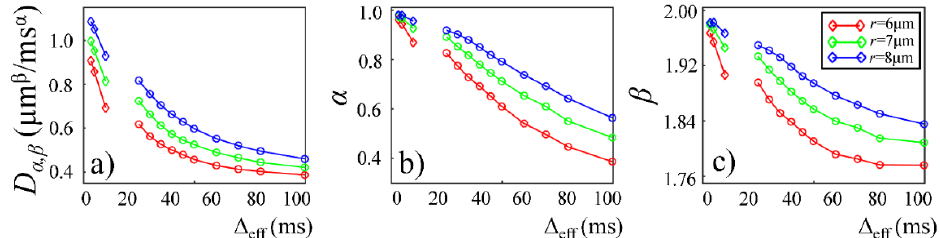
Figure 10. Plots of D α,β ( a ), α ( b ), and β ( c ) versus Δ eff from Monte Carlo simulation with fixed p = 0.2% and varying r of 6 µm (red), 7 µm (green) and 8 µm (blue). The rhombi and circles represent simulation results with oscillating diffusion gradient (OGSE) and Stejskal – Tanner diffusion gradient (PGSE/PGSTE), respectively.